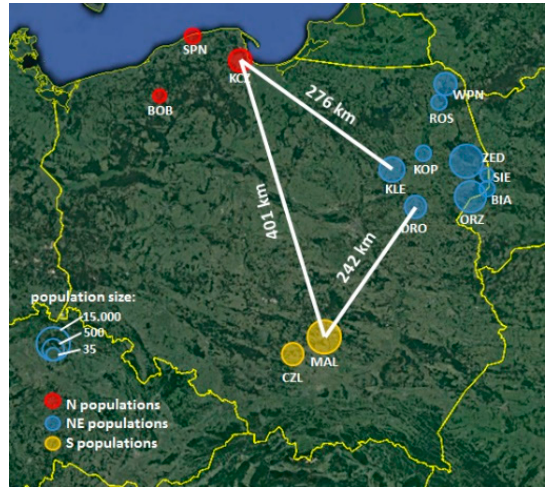
Figure 5. Distribution of Polemonium caeruleum study populations in Poland. The size of the circles corresponds to the log-transformed size of populations (number of flowering shoots), and the circle color corresponds to one of the three regions. The distances between the closest populations from each region are